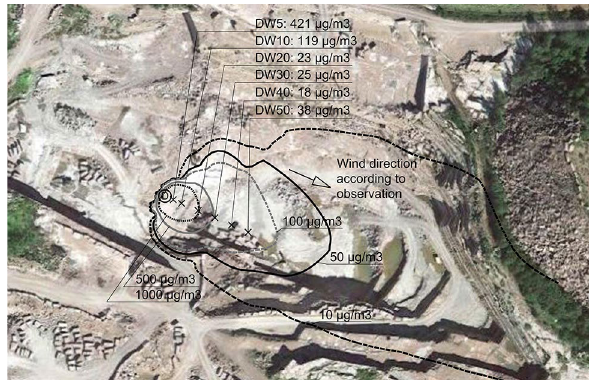
Fig. 4 Modelled concentration contours of the model D2 and the measured PM concentrations near the drilling. (D) denotes the 10 drill. X is the measurement location in the downwind (DW) direc- tion. Aerial photograph: Google Earth Pro